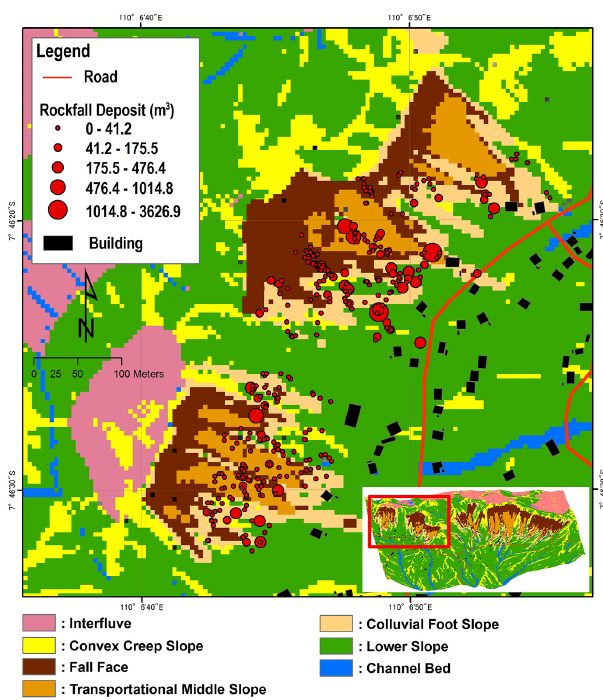
Figure 5. Distribution of rockfall boulders associated with elements at risk and generic